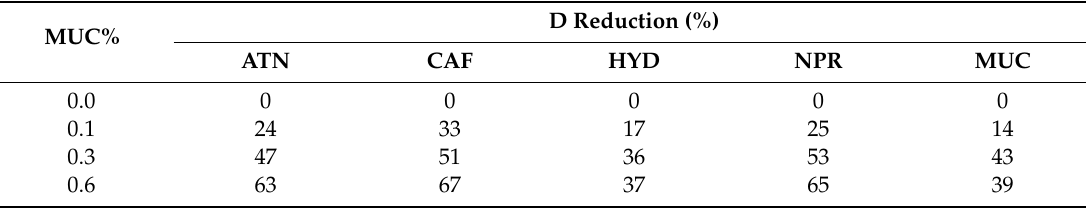
Table 3. Percentage reduction in di ff usivities (D) with increasing mucin concentrations (0.1–0.6% MUC) compared to the absence of mucin for ATN, CAF, HYD, NPR, and